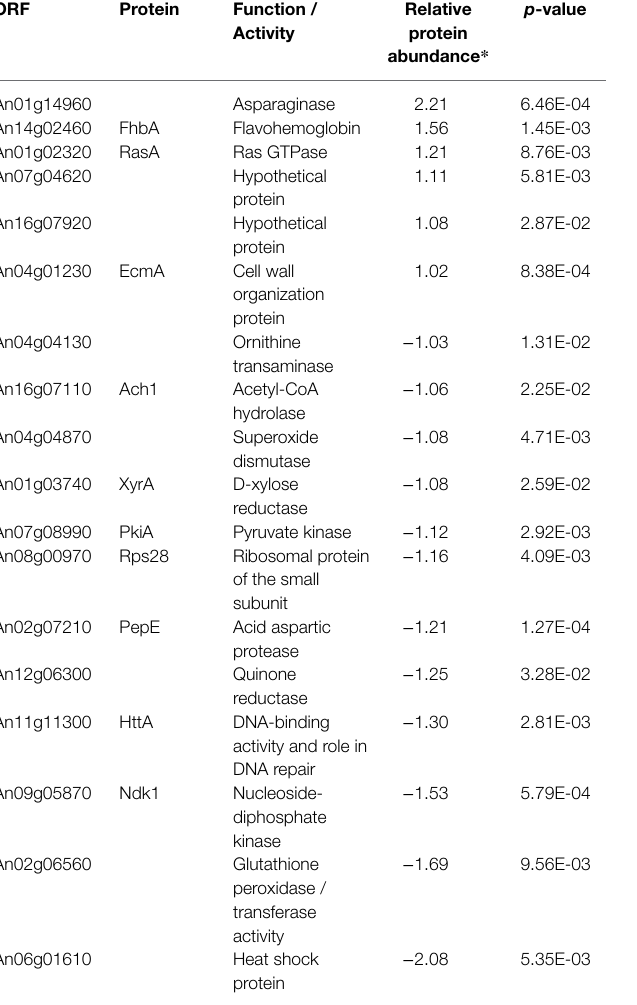
TABLE 4 | Differentially expressed proteins involved in stress response. TABLE 5 | Differentially expressed proteins involved in cellular amino acid metabolic